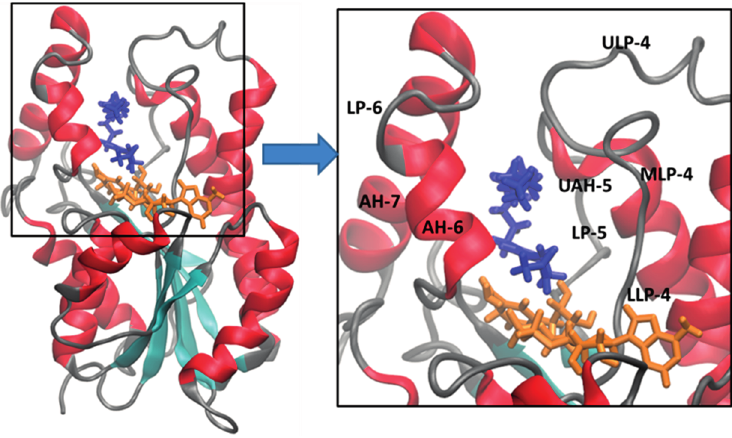
Figure 2. Cartoon of the 3D structure of the NADH-dependent enoyl-ACP reductase from Mycobacterium tuberculosis (InhA) in complex with the cofactor (blue) and a substrate mimic (THT, orange) (PDB ID: 1BVR), and a close view (box) of the substrate binding pocket, showing the following secondary structure domains: LLP-4 (Ser94-Pro99), MLP-4 (Gln100-Ile105), ULP-4 (Asn106-Asp110), LP-5 (Phe149-Ala157), UAH-5 (Tyr158-Lys165), AH-6 (Leu197-Val203), LP-6 (Gly204-Gly208), and AH-7 (Glu209-Arg225). Protein secondary structure color code: red ( α -helix), cyan ( β -sheet), and grey (loop or irregular or